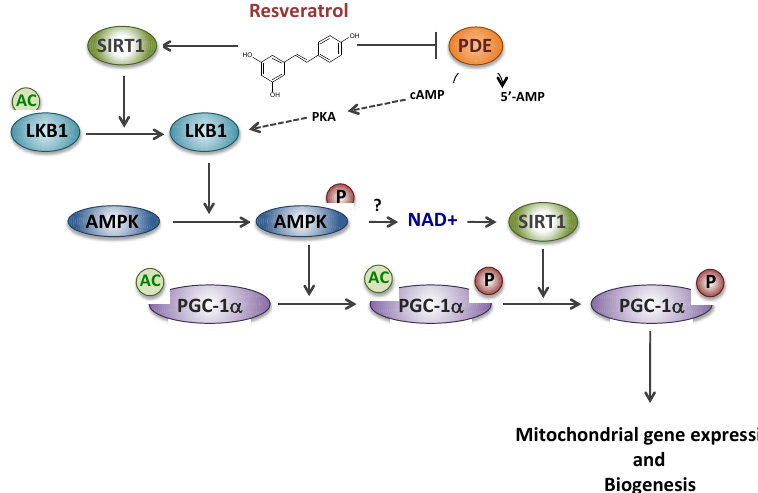
Figure 1. Resveratrol and putative signaling pathways involving SIRT1, AMPK and PDE. Sirtuin 1 (SIRT1), AMP ‐ activated protein kinase (AMPK), Phosphodiesterase (PDE), cyclic AMP(cAMP), Protein kinase A (PKA), Liver linase B1 (LKB1), PPAR gamma co ‐ activator 1 alpha (PGC ‐ 1 α ).